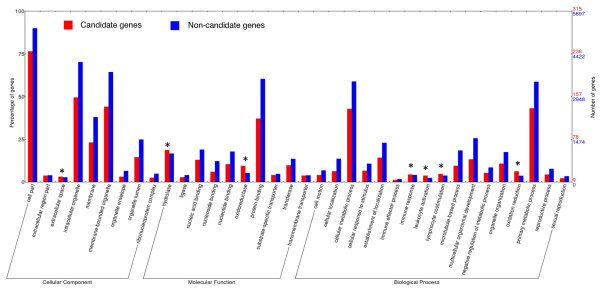
Comparison of Gene Ontology (GO) category (level 3) distribution between candidate genes and non-candidate gene.  The red and blue bars represent candidate genes (Ka/Ks ratio >0.5) and non-candidate genes (Ka/Ks ratio <0.5) in each GO functional category, respectively. Candidate genes have higher percentage then non-candidate gene in seven categories, which are marked with asterisks. The sum of individual percentages exceeds 100% because most genes are classified in multiple categories.